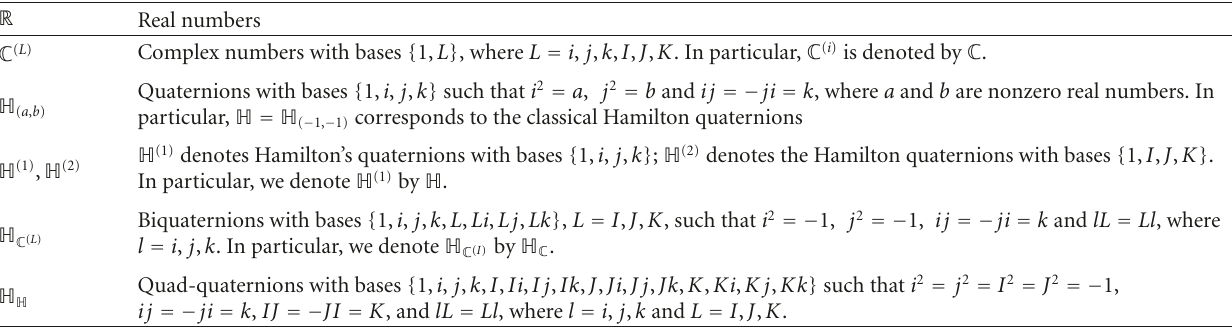
Table 1: Symbols of algebraic values.